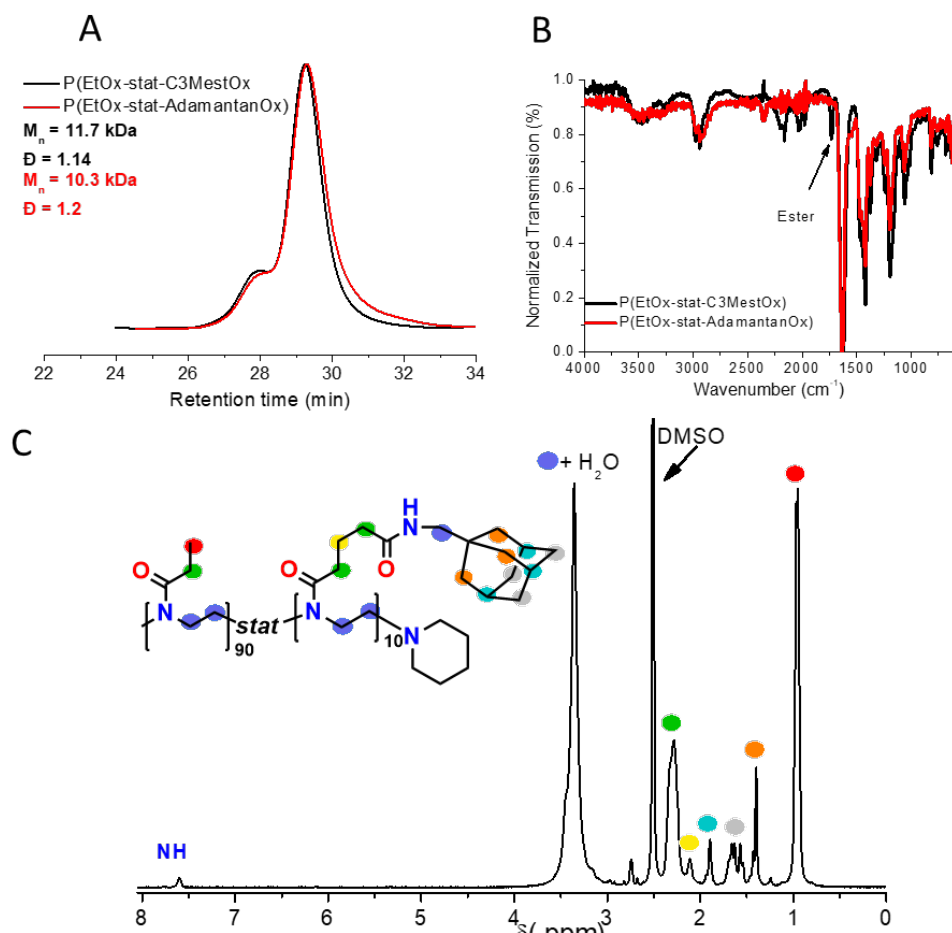
Figure 2. ( A ) Normalized RI traces of P(EtOx- stat -C3MestOx) in black and P(EtOx- stat -AdamantanOx) in red, with M n and Ð relative to PMMA standards. ( B ) FTIR spectra of P(EtOx- stat -C3MestOx) in black and P(EtOx- stat -AdamantanOx) in red. ( C ) Annotated 1 H NMR spectrum of P(EtOx- stat -AdamantanOx) measured in DMSO-d6 at room temperature. End-groups were not annotated for clarity